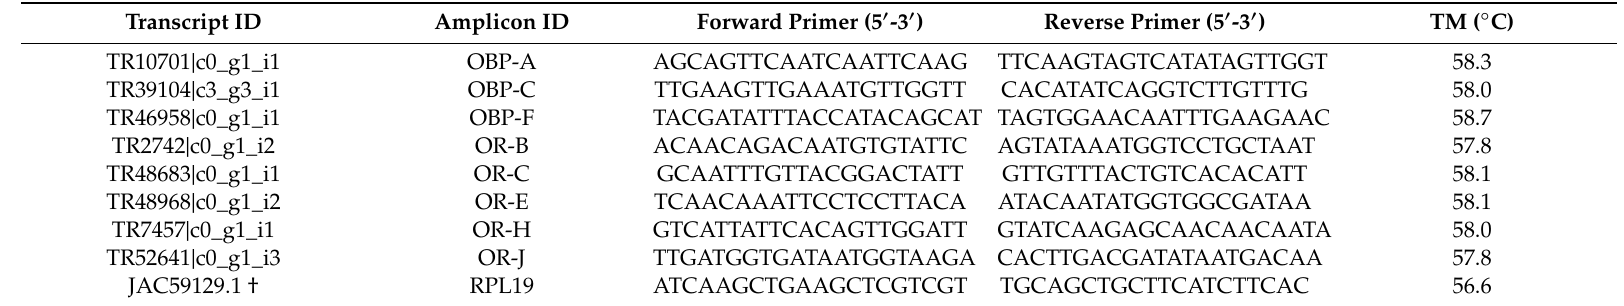
† indicates the coding sequence of the ribosomal protein L19 from A. ervi available at NCBI